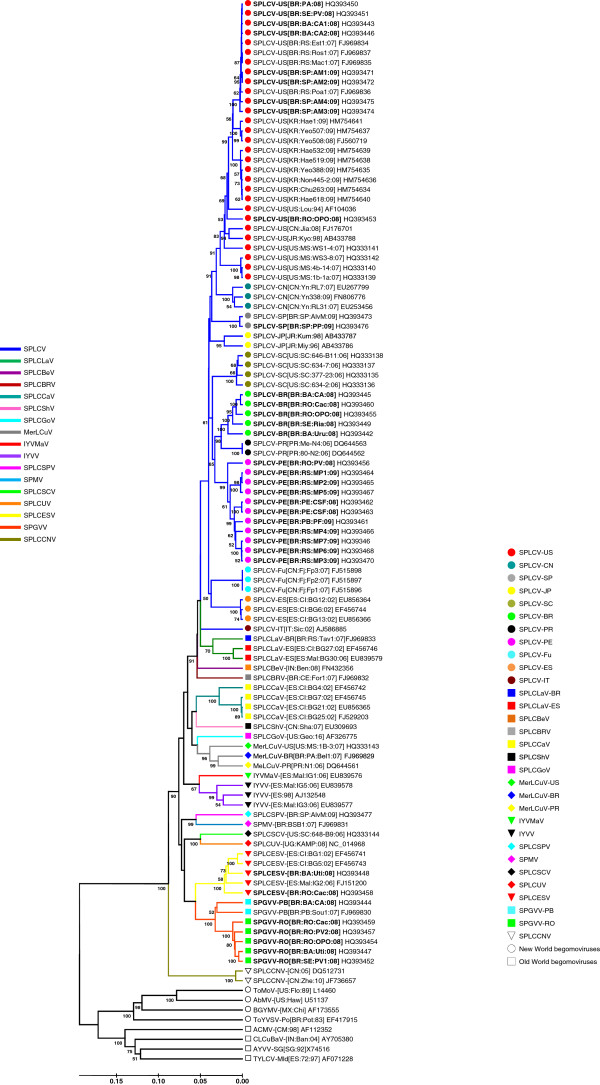
UPGMA phylogenetic tree based on a multiple alignment of the complete sequences of the sweepoviruses described in this work (in bold) and those available in public sequence databases. Branches were bootstrapped with 1,000 replications. Acronyms are described in Table 
1. Representative sequences are included for New World (L14460, Tomato mottle virus: ToMoV-[US:Flo:89]; U51137, Abutilon mosaic virus: AbMV-[US:Haw]; AF173555, Bean golden yellow mosaic virus: BGYMV-[MX:Chi]; and EF417915, Tomato yellow vein streak virus: ToYVSV-[BR:Ba3]) and Old World begomoviruses (AF112352, African cassava mosaic virus: ACMV-[CM:98]; AY705380, Cotton leaf curl Burewala virus: CLCuBuV-[IN:Ban:04]; X74516, AYVV-SG[SG:92]; and AF071228, Tomato yellow leaf curl virus: TYLCV-Mdl[ES:72:97]). The scale bar indicates the number of substitutions per site. Bootstrap values >50% are indicated.